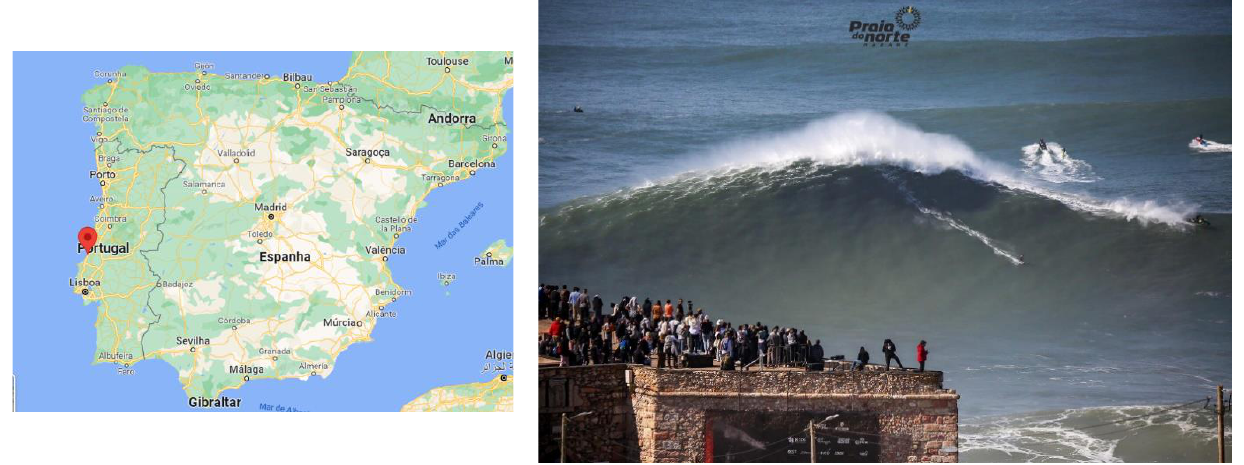
Figure 1 . Nazaré, Portugal (location map): surfer riding a big wave, the rescue team of water bikes and the spectators/big-wave chasers. Source: Facebook page of “Praia do Norte” 5 . The Nazaré Canyon is an undersea canyon just off the coast of Nazaré, Portugal, in the Eastern Atlantic Ocean. It has a maximum depth of at least 5000 m (16,000 ft) and is about 230 Table 1. Comparative evolution of the number of hotel guests, according to their home countries: in 2010 (before Garret McNamara’s first famous giant wave ride) and 2019 (the last available data without the effect of the COVID-19